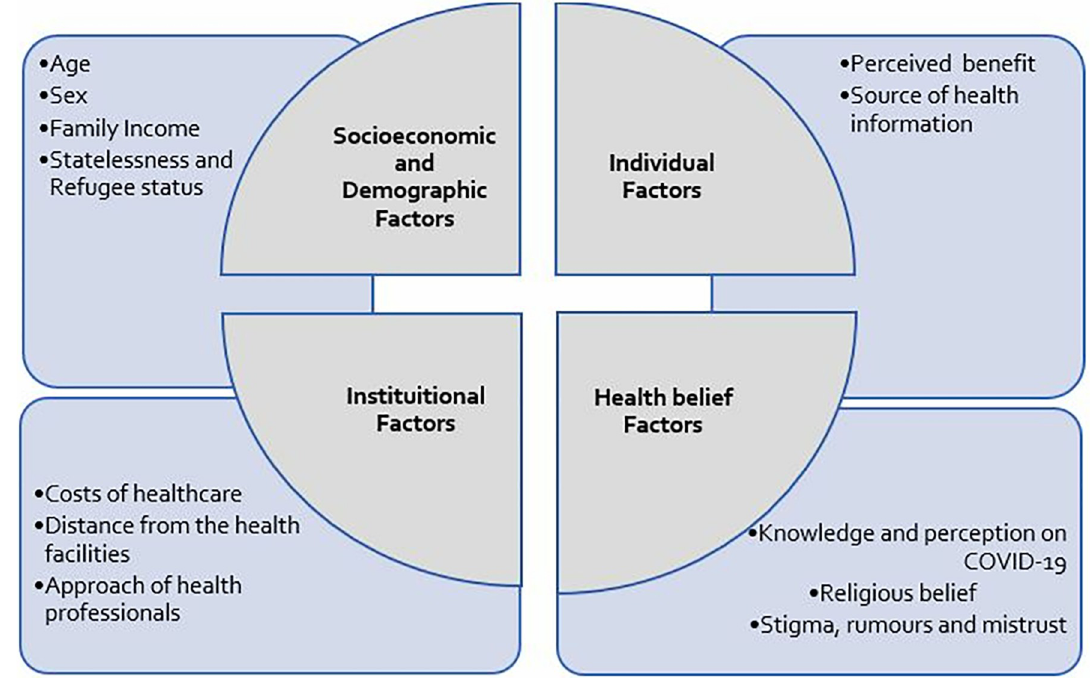
Fig 1. Conceptual framework of the study- The HSB-MVG conceptual framework.